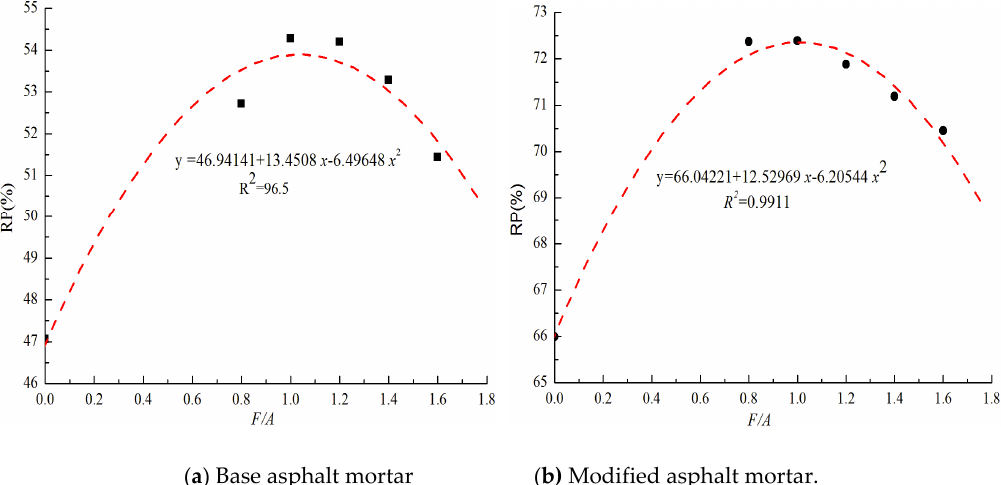
Figure 4. Penetration of asphalt mortar before and after UV aging.